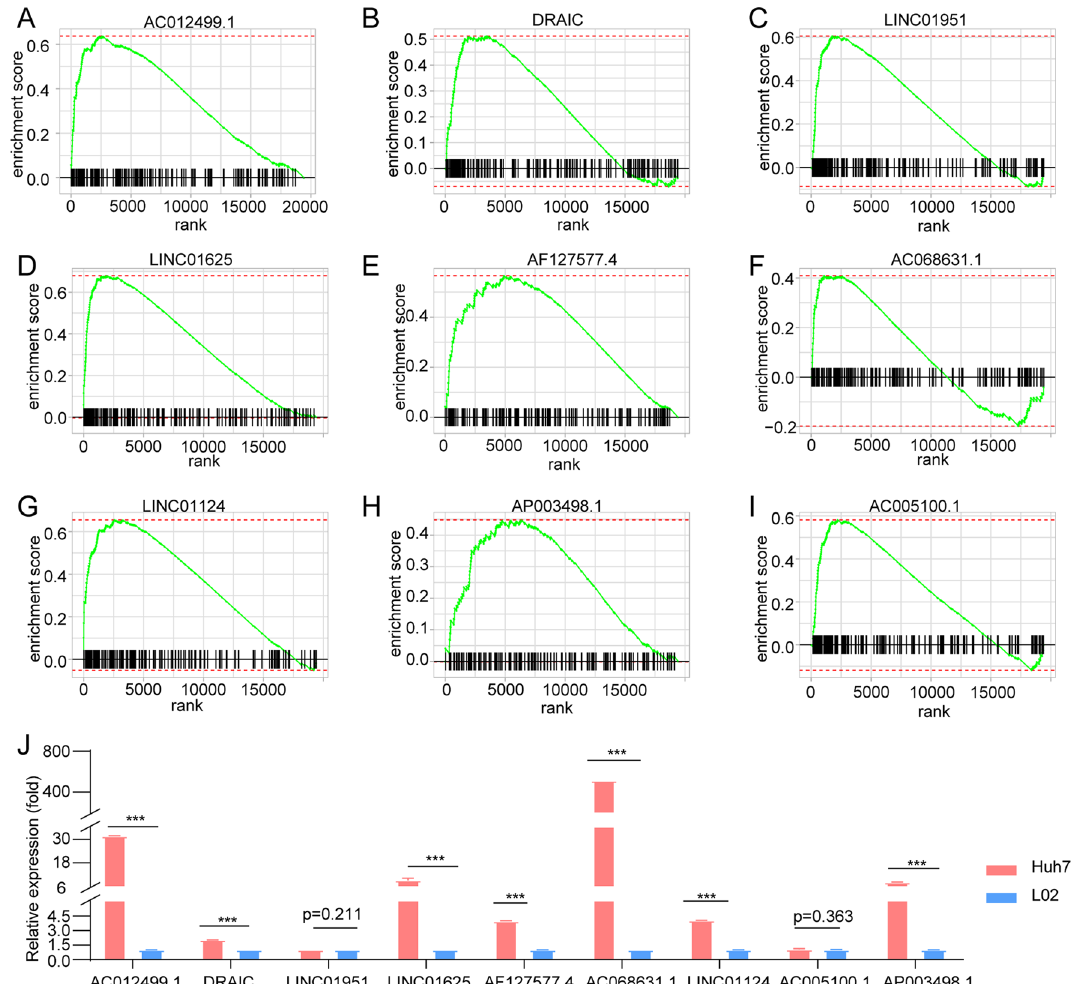
Figure 2. Validation of fatty acid-associated long noncoding RNAs (lncRNA)s. ( A – I ) Graphical display of the gene set enrichment analysis (GSEA) for top nine fatty acid-associated lncRNAs in fatty acid pathways (TCGA- LIHC). ( J ) Relative expression levels of nine lncRNAs in Huh7 and L02 cell